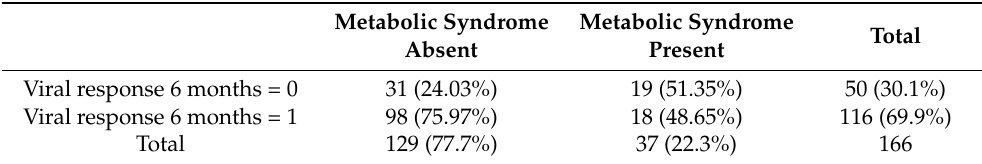
Table 6. Characterization of the patients’ lot in terms of metabolic syndrome.